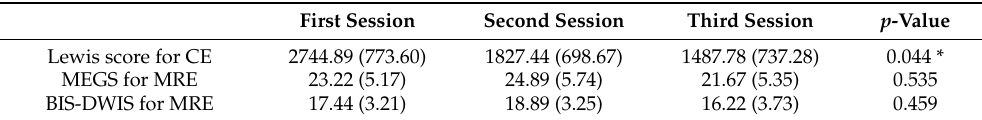
Table 4. Time-dependent differences according to the sessions on Lewis score for CE, MEGS for MRE and BIS-DWIS for MRE on 9 patients.